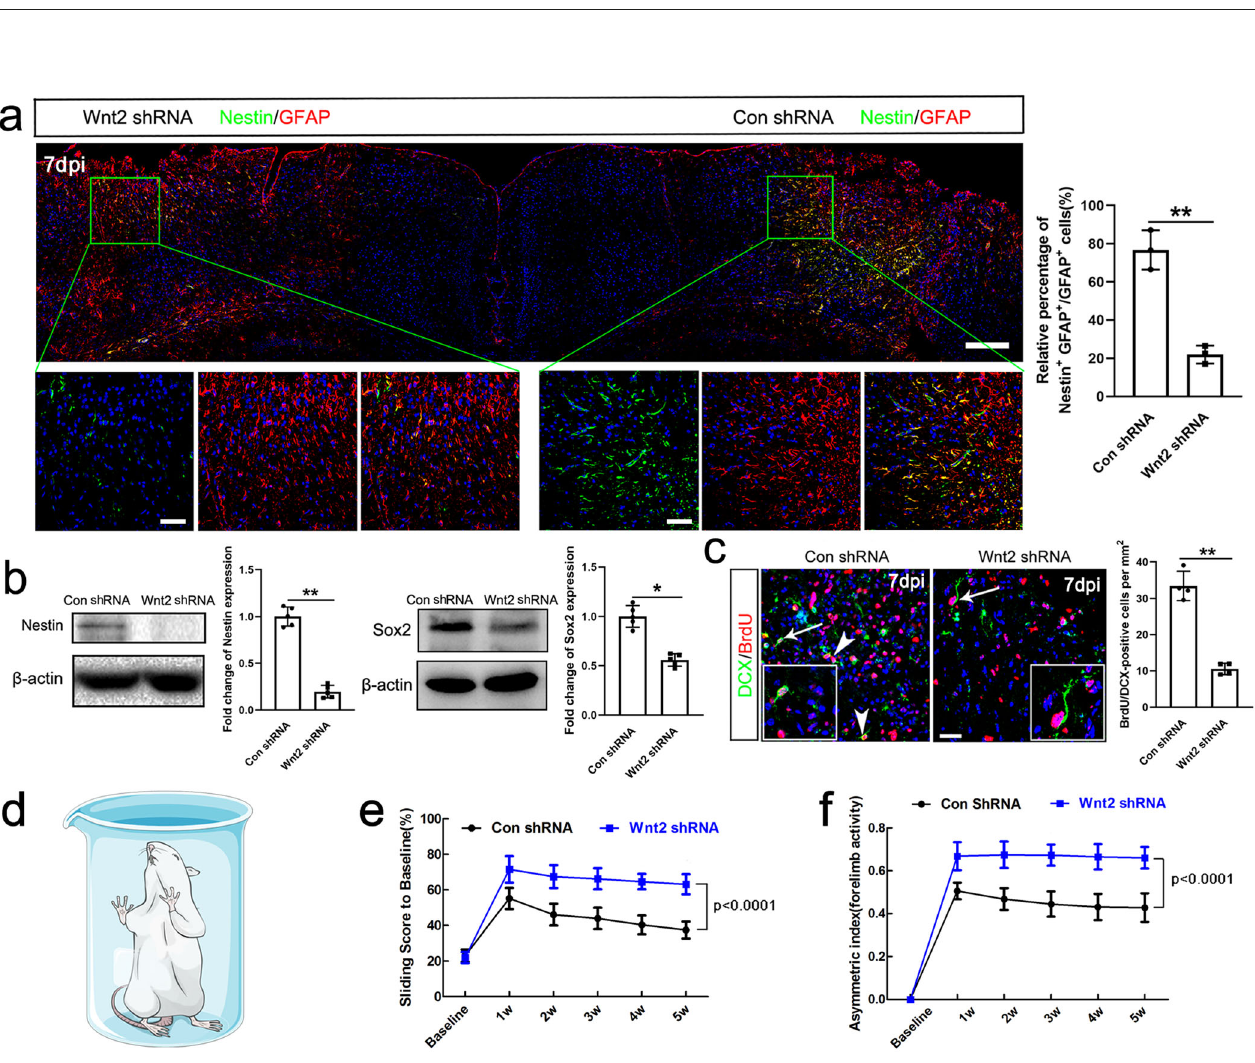
Fig. 2 Up-regulation of Wnt2 by apoptotic neurons and its involvement in Wnt// β -catenin signaling activation. a Double-immunostaining of NeuN/Wnt2 in normal cortex. Bar = 50 μ m. b , c Western-blotting of Wnt2 at different time points in ischemic cortex. Notice that Wnt2 protein increases quickly after ischemia. * P = 0.026 (1 h), 0.028 (2 h), 0.024 (4 h), 0.048 (8 h), 0.043 (12 h). One-way ANOVA followed by Bonferroni ’ s post hoc comparisons tests. N = 4 mice per group. d Combination of TUNEL staining and Wnt2 immunostaining at 24 hpi. Wnt2 high immunoreactivity overlapped well with TUNEL-staining (arrowheads). Dashed line indicates lesion border and asterisk indicates lesion area. Bar = 30 μ m. e Representative image of TUNEL/Wnt2/NeuN-triple immunostaining in the lesion area. Bar = 10 μ m. f , g Western- blotting of Wnt2 in conditioned medium of normal cultured (NNCM), apoptotic (ANCM), Wnt2 shRNA pretreated apoptotic (shRNA ANCM) wild type and caspase-3 − / − neurons. Apoptotic neurons increase Wnt2 release into the culture medium, and this increase is compromised by caspase-3 ablation and Wnt2 shRNA. BSA was used as internal control. * P NNCM vs ANCM = 0.012, * P ANCM vs ShRNA-ANCM = 0.014. One-way ANOVA followed by Bonferroni ’ s post hoc comparisons tests. N = 3 batches of cells. h Western-blotting of active β -catenin in the cytoplasmic and nuclear protein of astrocytes treated by NNCM, ANCM, AICM or shRNA ANCM. ANCM greatly increases the level of β -catenin in nuclear protein. LMNB1 was used as nuclear protein control. i Double-immunostaining of GFAP/ β -gal in Topgal mice pretreated with Wnt2 shRNA. Arrows point to representative double-positive cells. Bar = 50 μ m. j Western-blotting of β -gal and Axin2 in ischemic cortex of Topgal mice treated with Wnt2 shRNA or control. Left: * P ipsi vs ipsi + Wnt2-shRNA = 0.038, * P ipsi + Con-shRNA vs ipsi + Wnt2-shRNA = 0.041, Right: * P ipsi vs ipsi + Wnt2-shRNA = 0.013, * P ipsi = 0.016. One-way ANOVA followed by Bonferroni ’ s post hoc comparisons tests. N = 3 mice per group. Notice the + Con-shRNA vs ipsi + Wnt2-shRNA less induction of β -gal and Axin2 in Wnt2 shRNA pretreated cortex. Mean ± standard error (SE). Asterisks indicate the comparison with control group. Asterisks with bars connecting two groups indicate difference between these two groups.